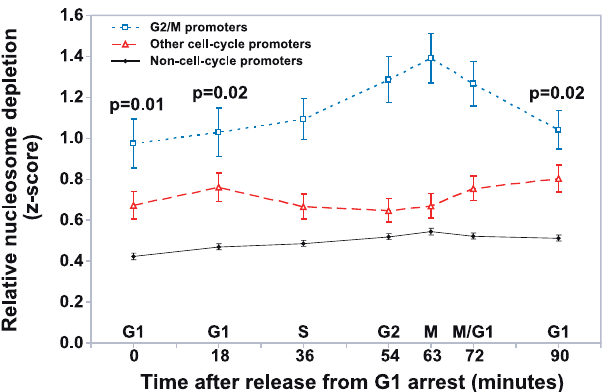
Figure 8. Relative to Other Promoters, G2/M Promoters Are Nucleosome Depleted throughout the Cell Cycle. The broken blue line indicates the mean z -score of FAIRE enrichment of unidirectional G 2 /M promoters at each time point throughout the cell- cycle. The mean of all other cell cycle unidirectional promoters (broken red line) and non–cell cycle promoters (solid black line) are also shown. The error bars indicate 6 SEM. The p -values for the significance of the difference between the blue and red lines were derived from 1,000,000 permutations of the data (Materials and Methods). The p -values for 0, 18, and 90 are relevant since they represent ‘‘ baseline ’’ occupancy (time points comprising the peak were all less than 0.0002.) DOI: